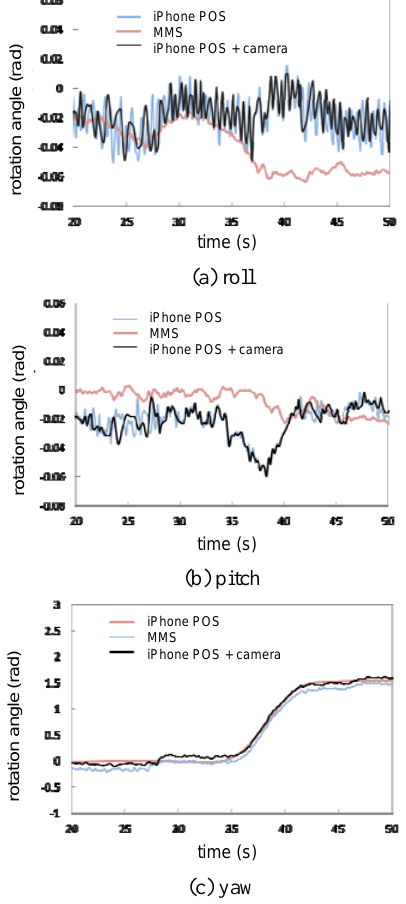
Figure 9. Results of rotation angle with all sensors